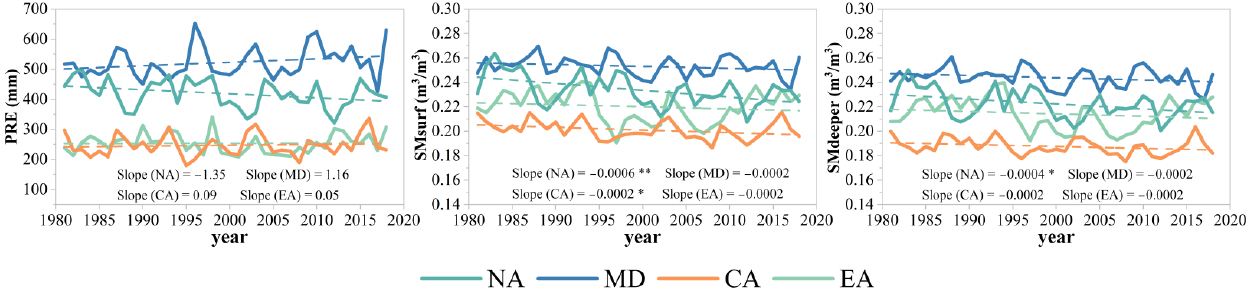
Figure 11. Temporal variation lag effect of precipitation on vegetation LAI in four study regions: ( a ) North America, ( b ) Mediterranean region, ( c ) Central Asia, and ( d ) East Asia. 3.3.3. Long-Term Vegetation LAI Changes under the Influence of Precipitation and Soil Moisture